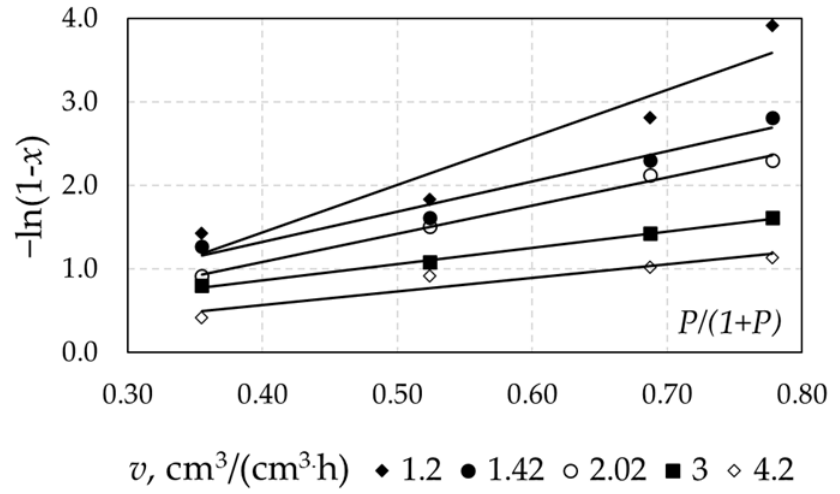
Figure 3. Correlation between − ln(1 − x ) and P/(1 + P ) over different volumetric flow rate ( υ ) of the diesel fraction.